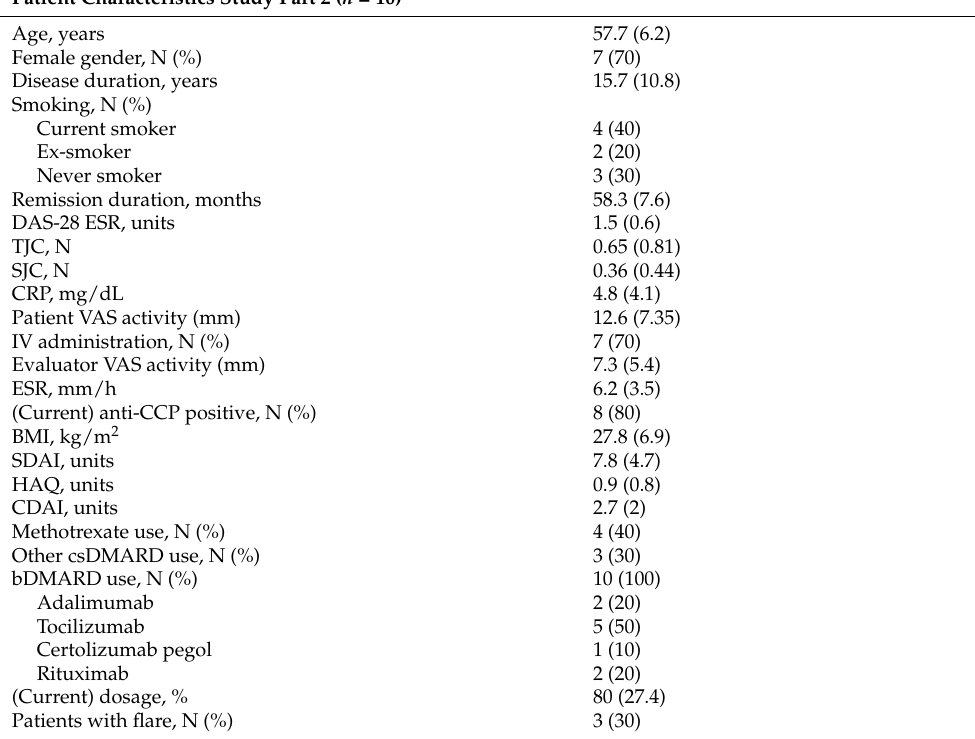
Table 2. Characteristics of the 10 patients included in part 2. Values were aggregated over the whole visit history if not stated otherwise. Smoker status was only available for 9 out of 10 patients. CRP —C-reactive protein; DAS28 —disease activity score 28 joints; TJC —tender joint count; HAQ —health assessment questionnaire; SJC —swollen joint count; VAS —visual analytics scale; SDAI —simple disease